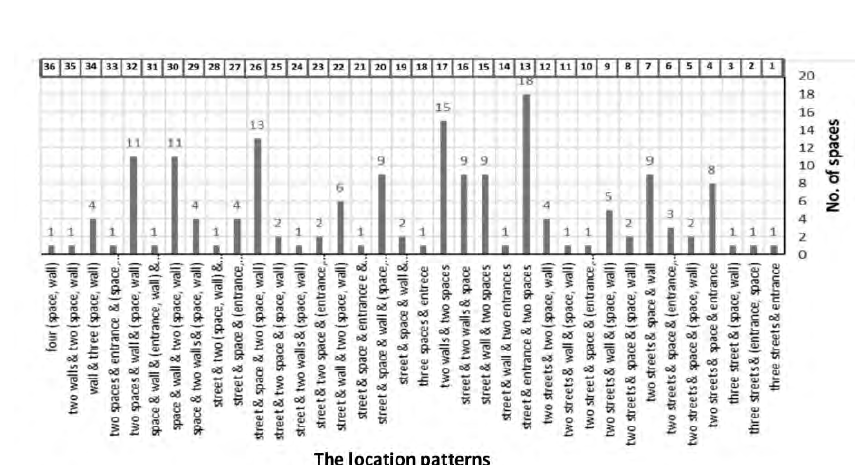
Figure 2. The spaces’ location patters classification in the third neighborhood in Sheikh Zayed city’s first